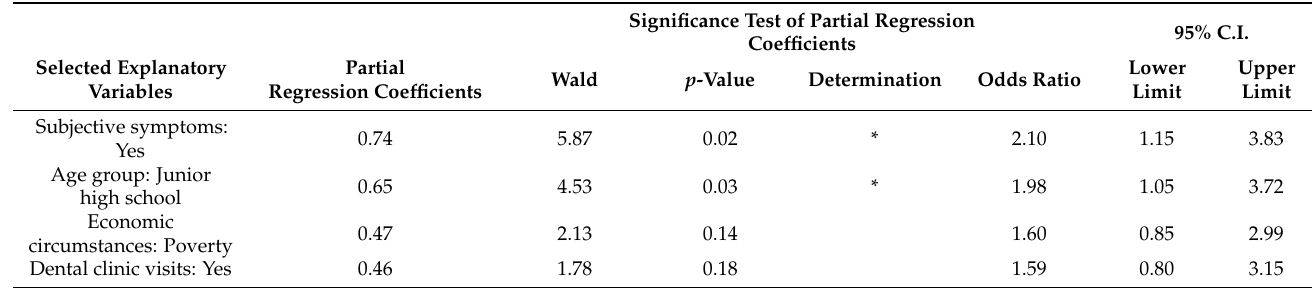
Table 6. Results of logistic regression with perceived health status as the objective